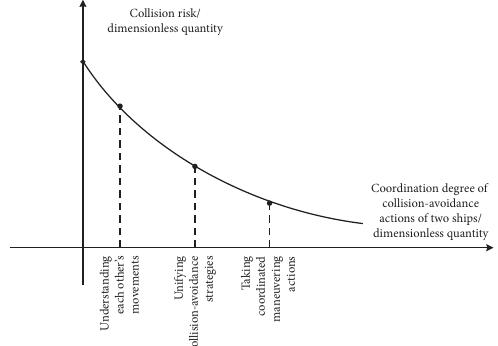
Figure 13: Relationship between coordination degree and collision risk of two